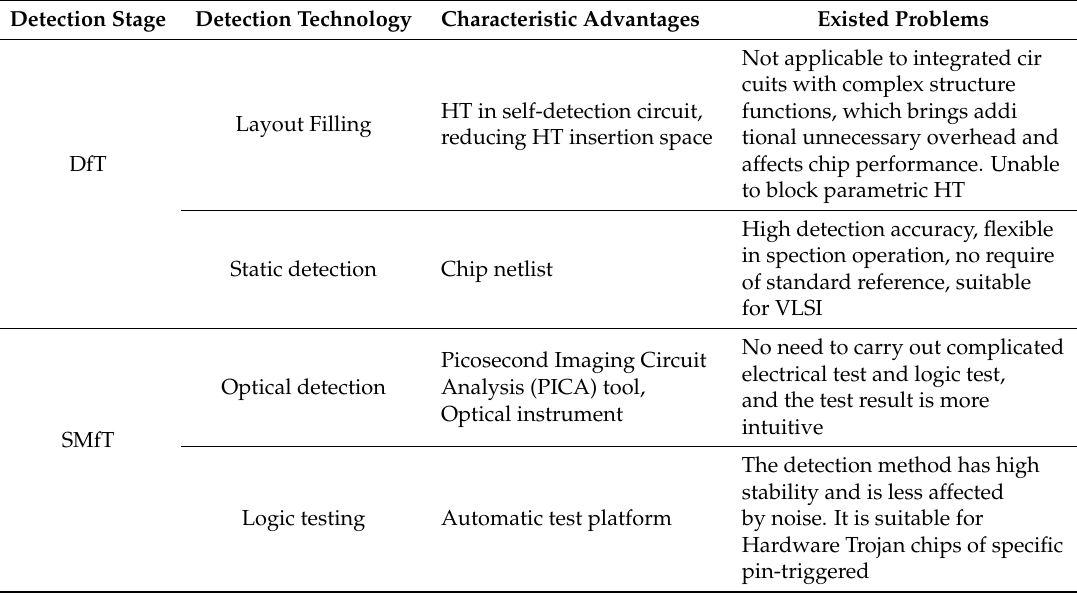
Table 4. HTs prevention techniques